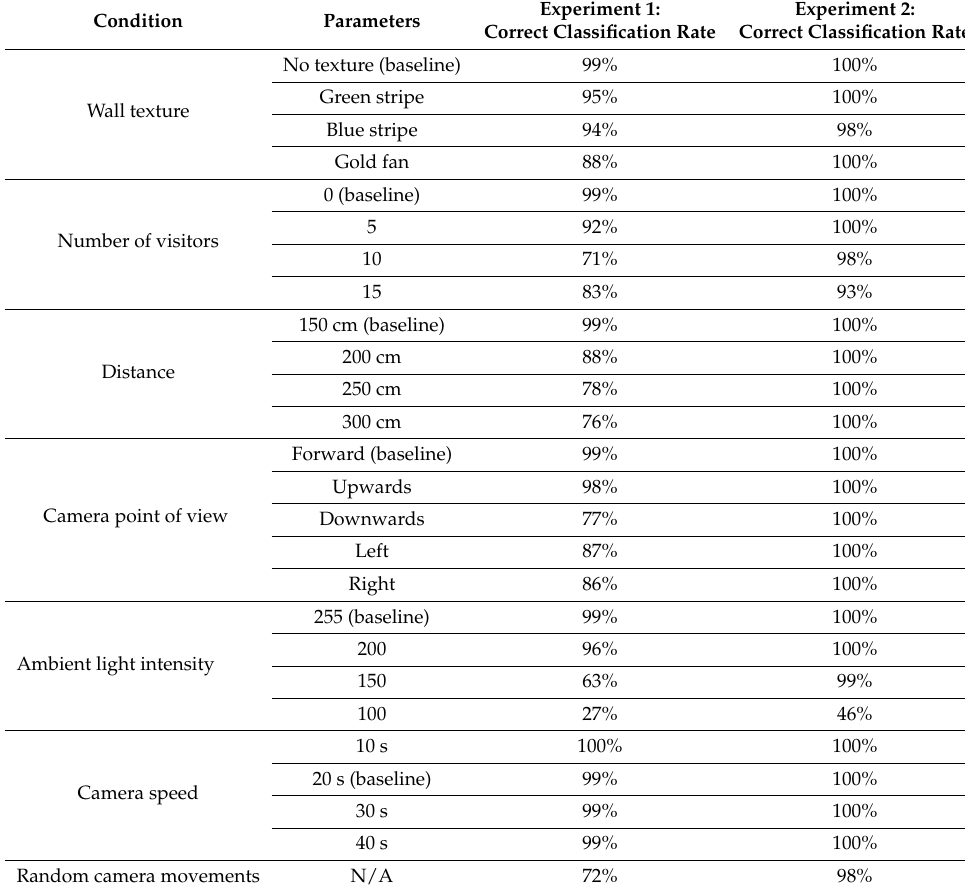
Table 1. Recognition rates for different simulated conditions. Condition Parameters